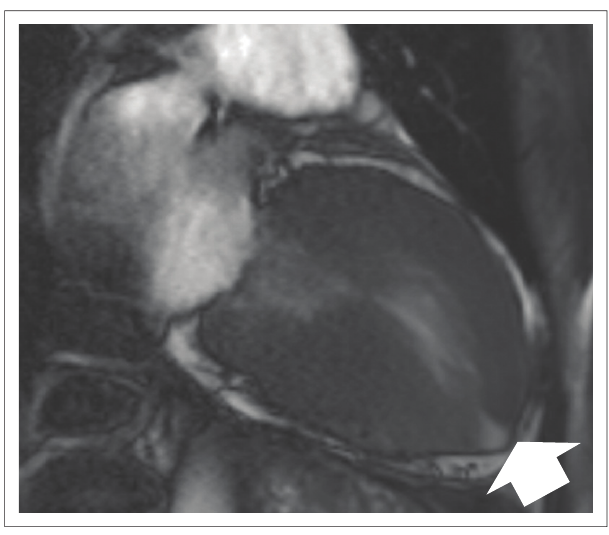
Source : James C. Moon FIGURE 5: Basal inferior crypts; these are best seen in diastole. More than two is associated with